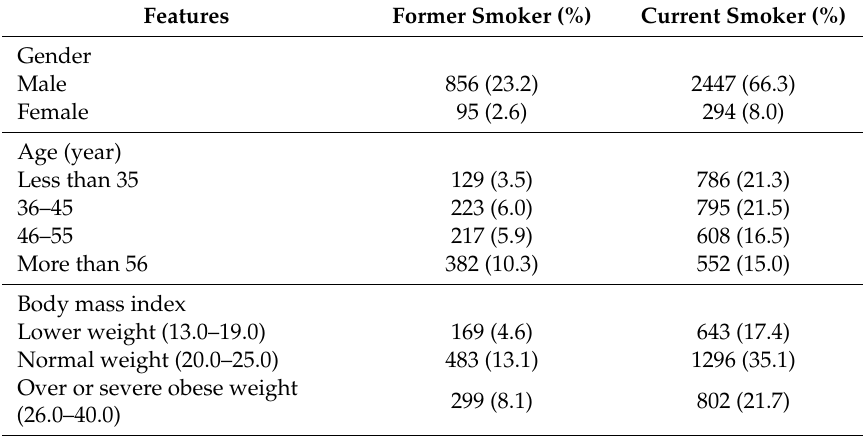
Table 2. Basic characteristics of the subjects for smoking